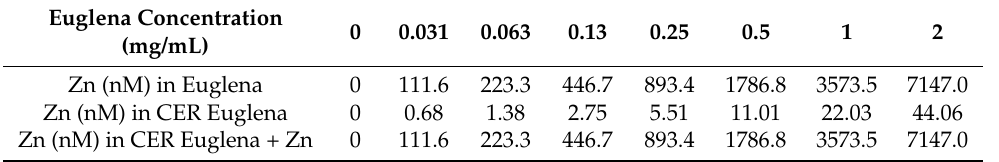
Table 2. Zinc concentration in each Euglena extract. CER, cation exchange